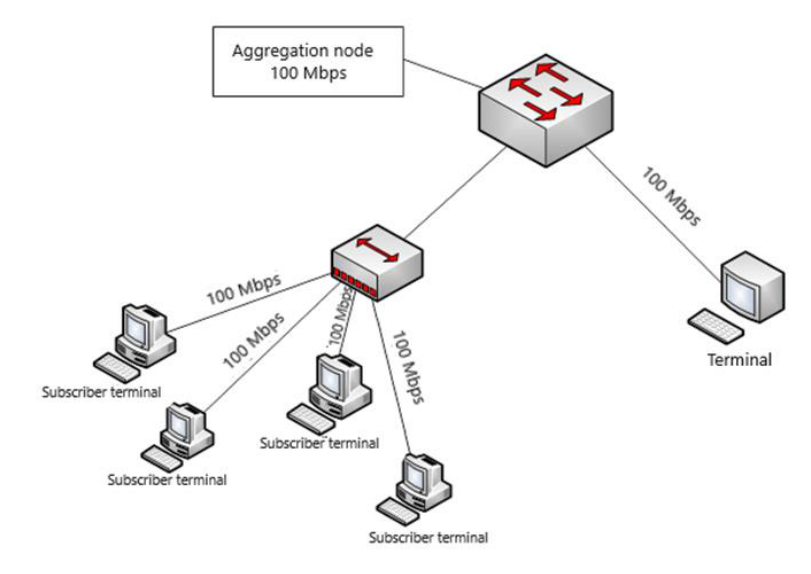
Figure 1. The scheme of organization of communication